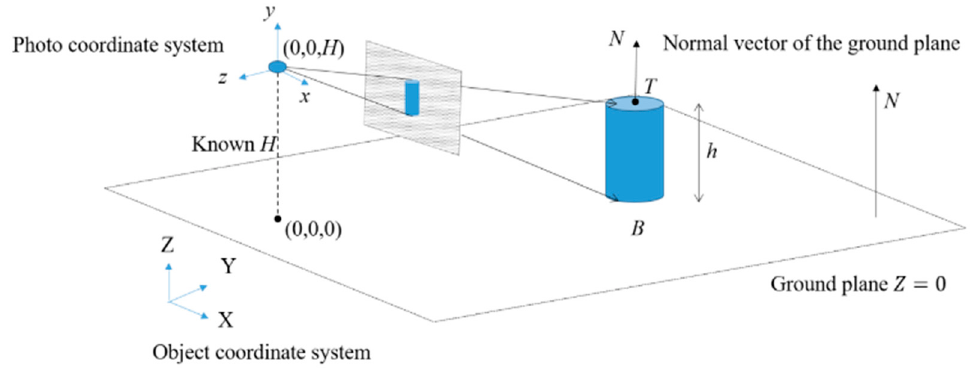
Figure 5. The illustration of the configuration between a camera and an object, where H is a prior known camera height in object coordinate system; N is the normal vector of the ground plane; T and B are the unknowns that indicate the top and bottom points used for calculating the object height h.